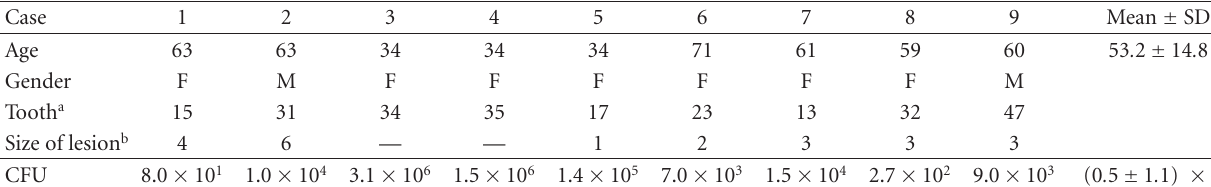
Table 1: Clinical features of subjects and bacterial amounts in the present